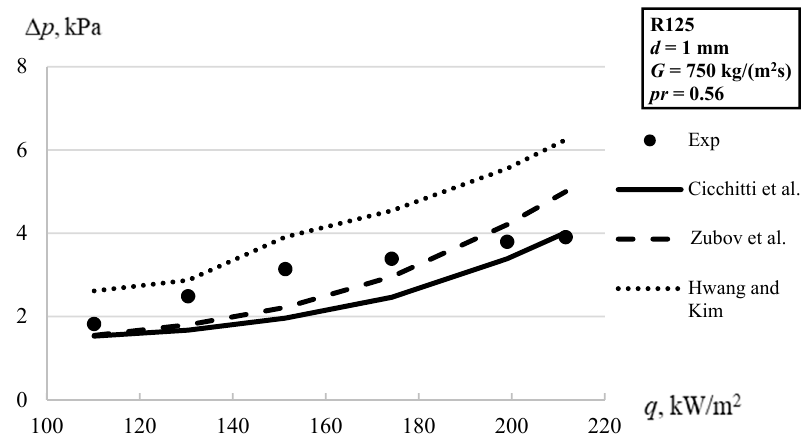
Figure 7. Pressure drop versus heat flux for experimental and calculated data at G = 750 kg/m 2 s and p r = 0.56.